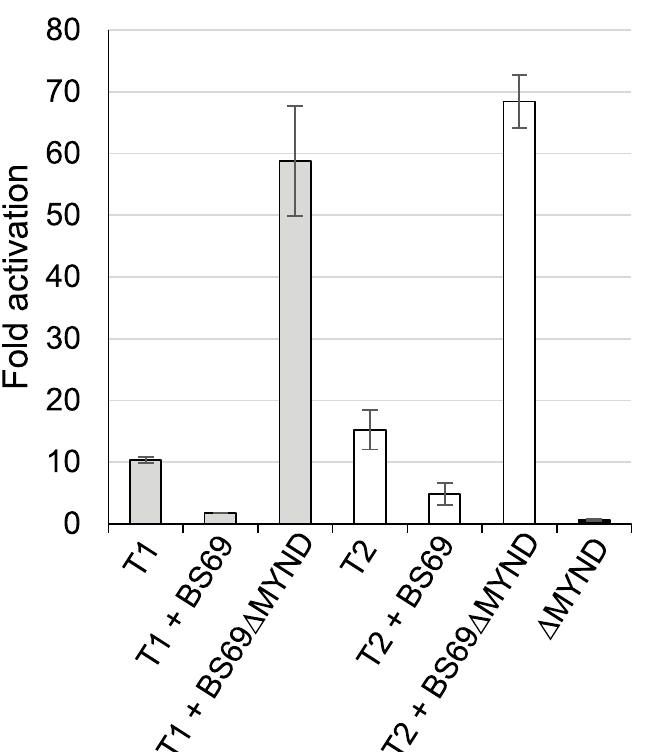
Fig 10. Expression of a dominant negative form of BS69 increases EBNA2 transactivation. Transactivation assays in BJAB cells using EBNA2-GAL4-DNA binding domain fusion proteins and a GAL4 reporter plasmid. Cells were cotransfected with 300 ng of either type 1 GAL4-DBD:EBNA2 (aa 334–487) or type 2 GAL4-DBD:EBNA2 (301–454) constructs, 500 ng of pFRLuc (Gal4 firefly luciferase reporter), 10 ng of pRL-CMV and 1 μ g of BS69 (pCI-BS69) or BS69 Δ MYND (pCI-BS69- Δ MYND) expressing plasmids. For each sample, firefly luciferase values were normalised for transfection efficiency using Renilla luciferase values. Results are presented as luciferase activity relative to the pFR-Luc reporter plasmid plus empty vector (pcDNA3.1-GAL4-DBD). BS69 Δ MYND was also transfected in the absence of EBNA2 expressing constructs. Results show the mean of two independent experiments ± standard